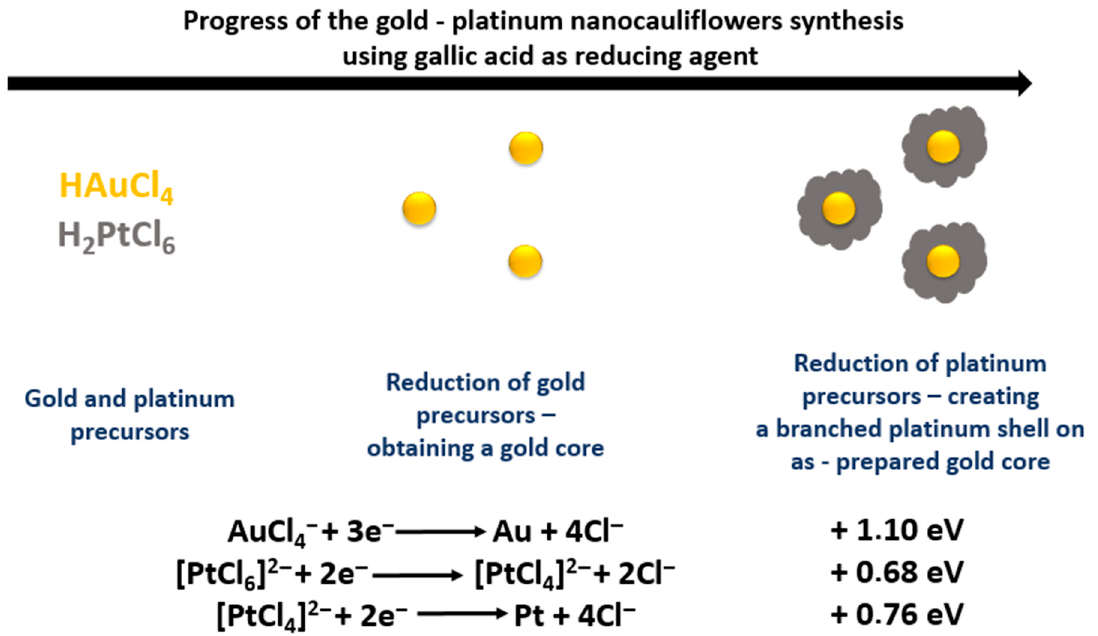
Figure 2. Synthesis mechanism of AuPt nanocauliflowers (NCs) using gallic acid.